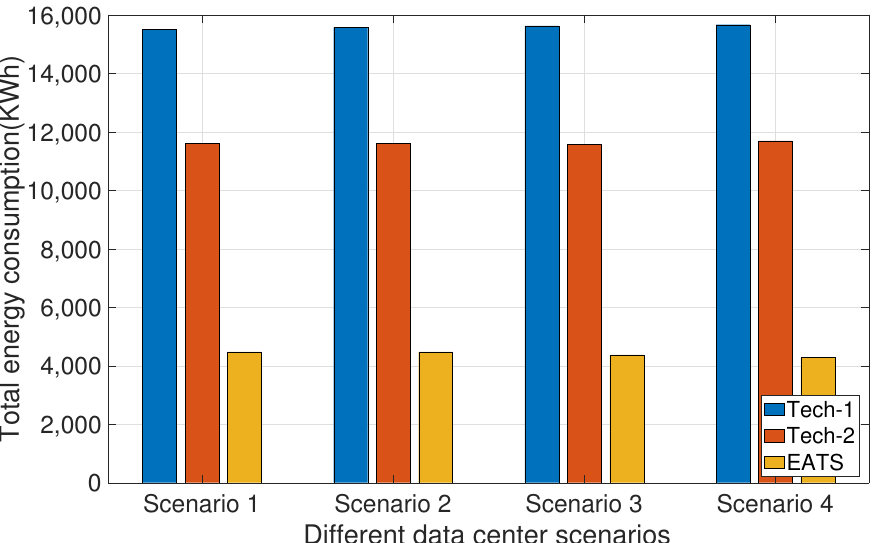
Figure 9. Comparison results of the total energy consumption with different data center scenarios.